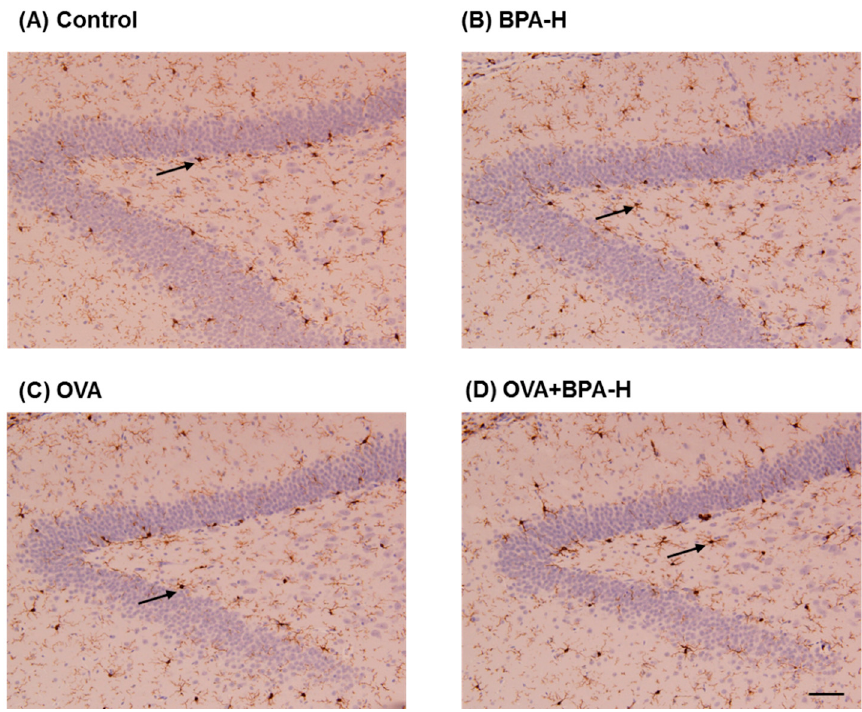
Figure 8. Representative photomicrographs showing the DG (dentate gyrus) area of the hippocampi immunostained with Iba1 in ( A ) control, ( B ) BPA-H, ( C ) OVA and ( D ) OVA+BPA-H exposed mice. Black arrows indicate activated microglia. Scale bar = 50 μ m.